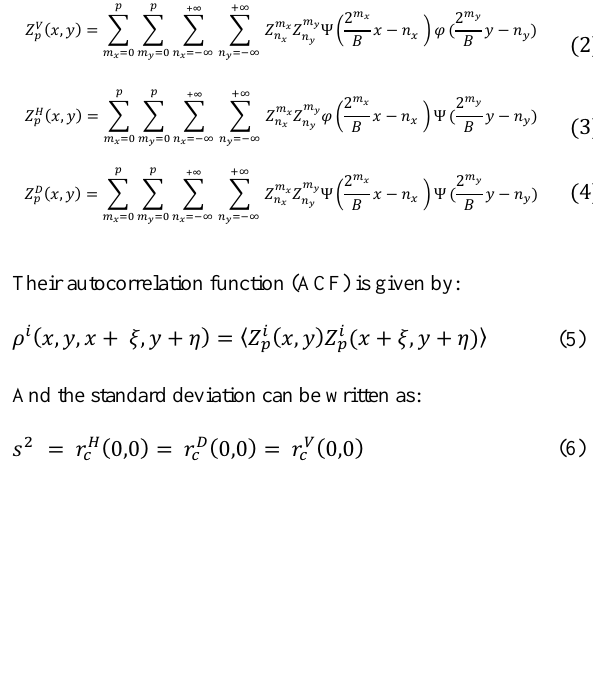
In figure 1 and figure 2 the vertical, diagonal and horizontal component of a multi-scale two dimensional ACF surface are represented.